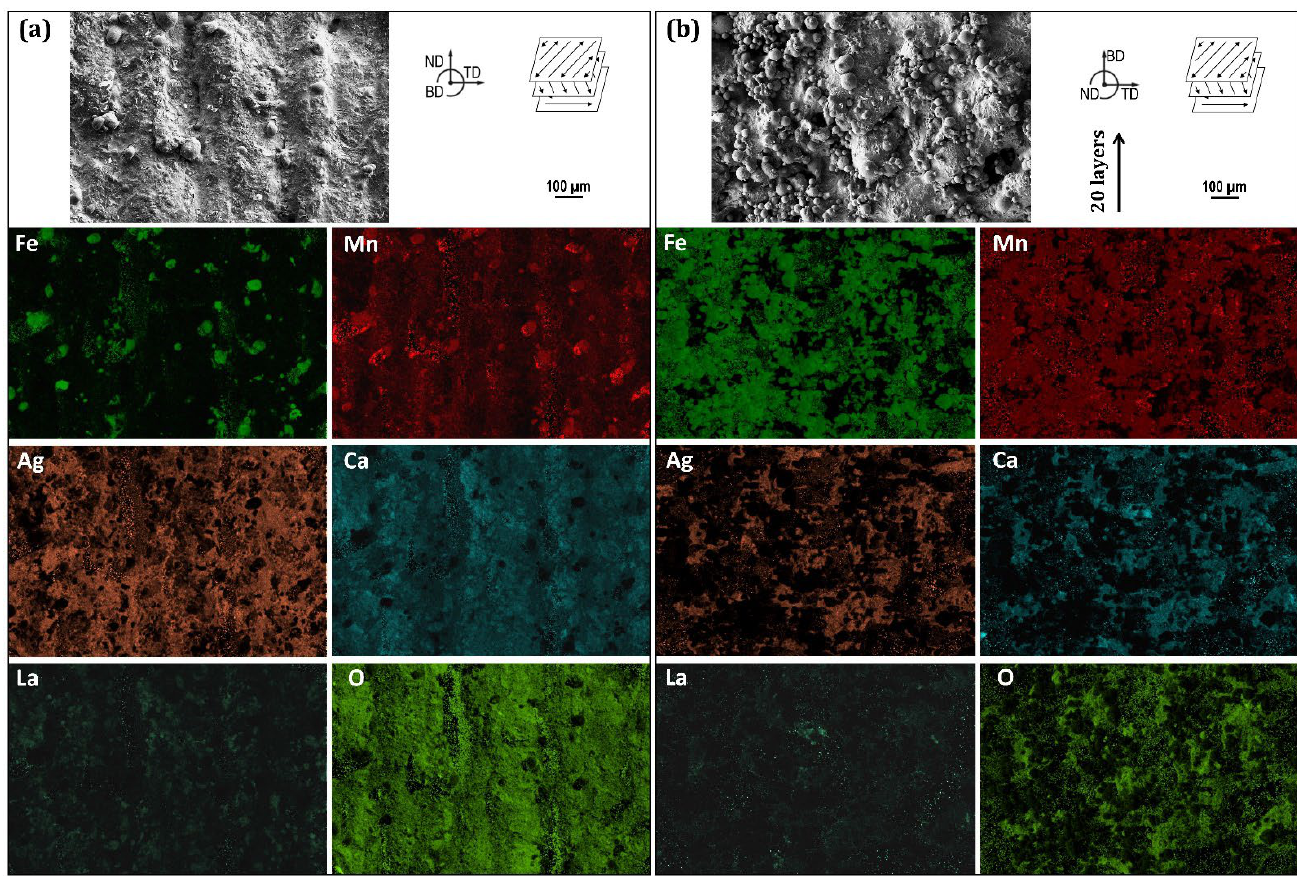
Figure 2. Corresponding SEM-SE and SEM-EDS of as-built surfaces (HD): ( a ) top surface with enrichment of Ag and O, ( b ) side surface.